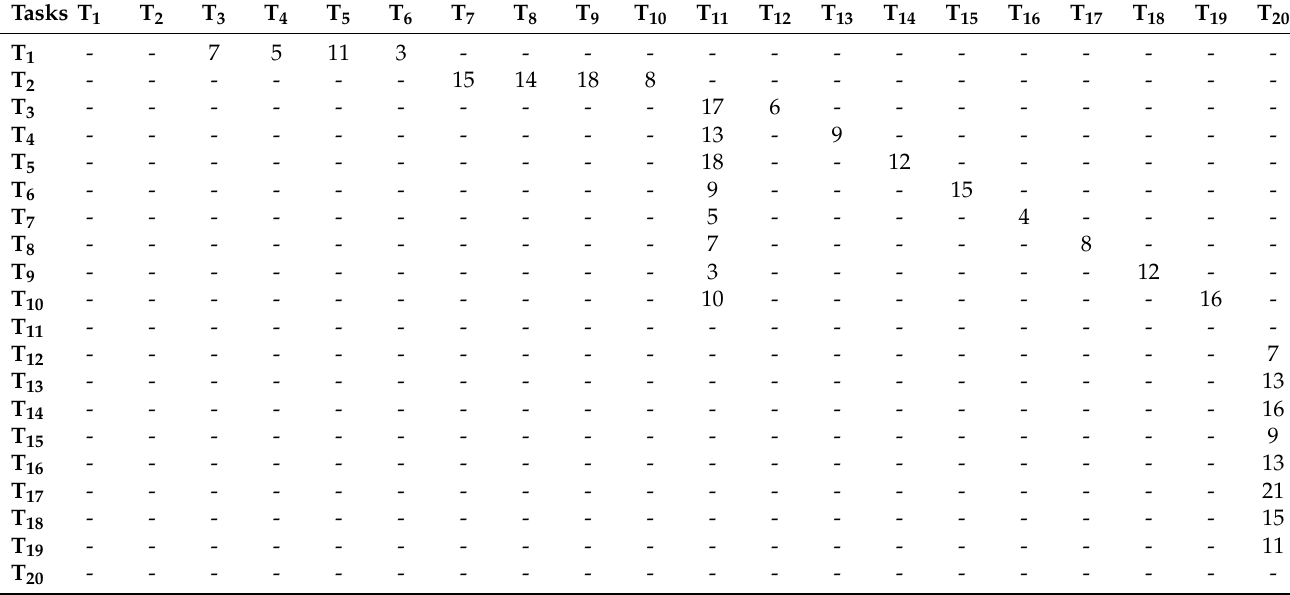
Table 3. Data Transfer Time (DTT) between the tasks.